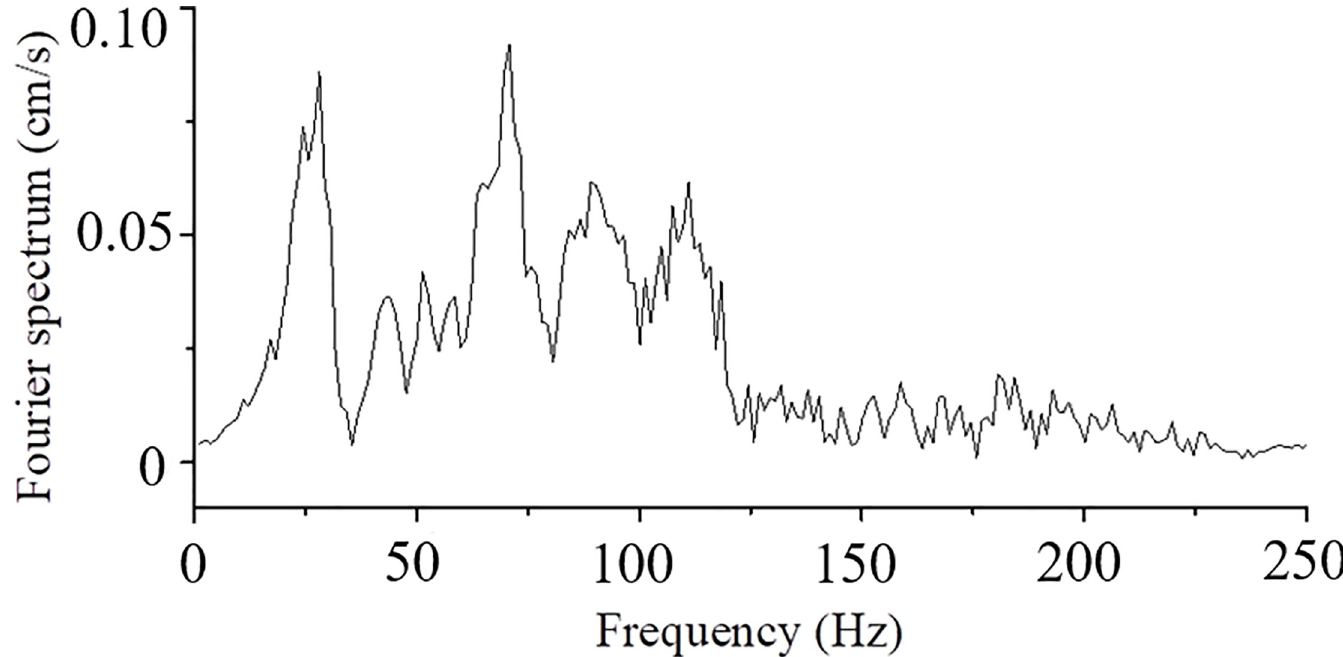
Fig 9. Frequency domain of tunnel blasting using non-electric detonators (Part I